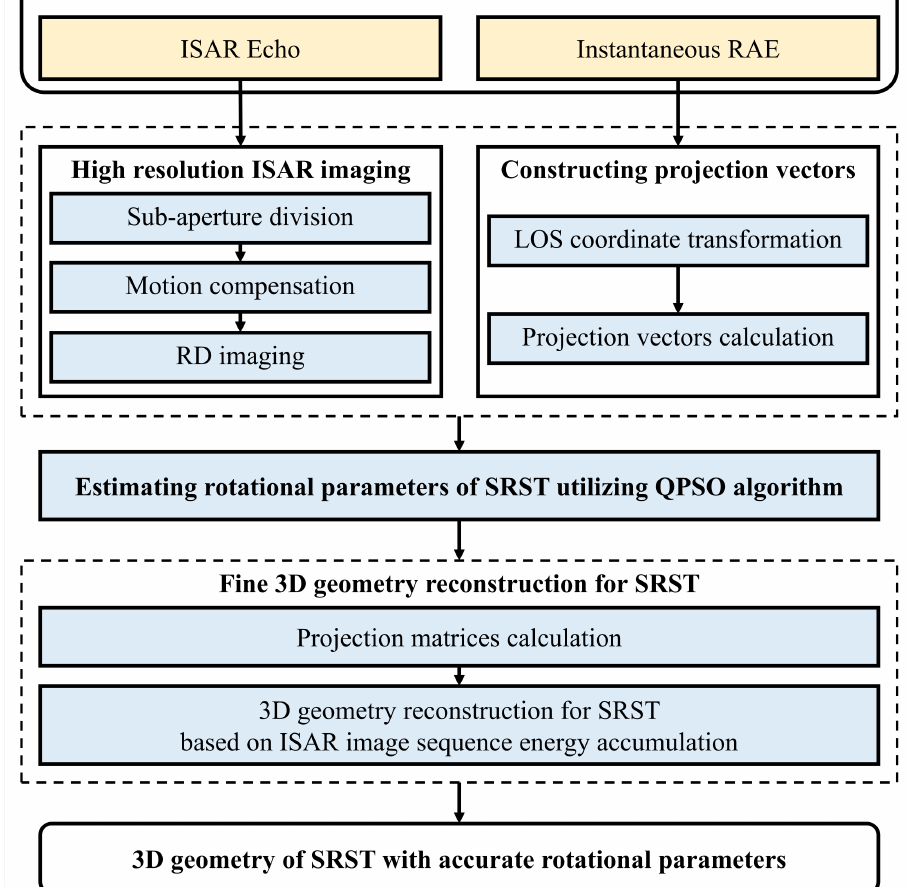
Figure 2. Flowchart of the proposed